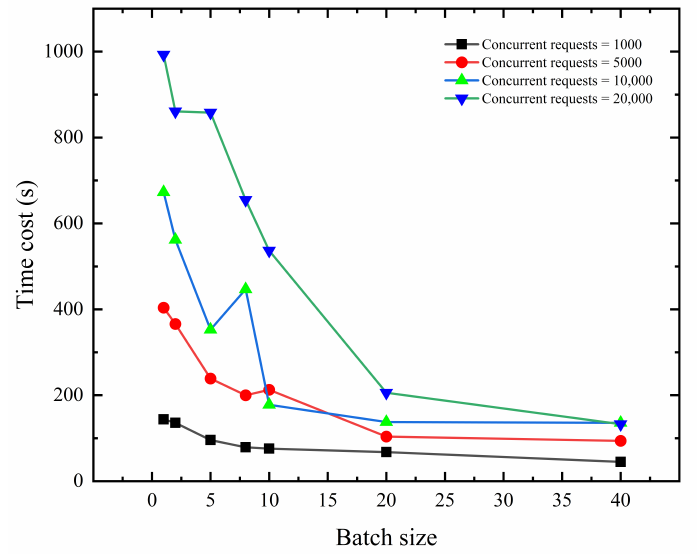
Figure 11. Time cost (s) of the protocol “Access Control Verify” in the environment with many concurrent